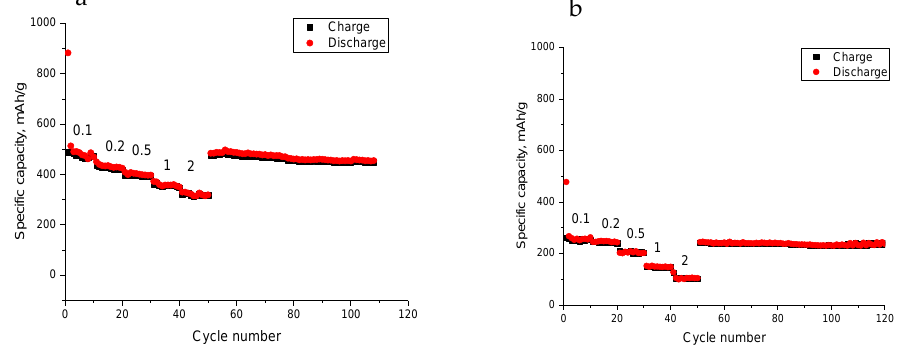
Figure 6. C-rate performance of the flexible (a) MoS 2 @Ge/CNFs and ( b ) Ge/CNFs.